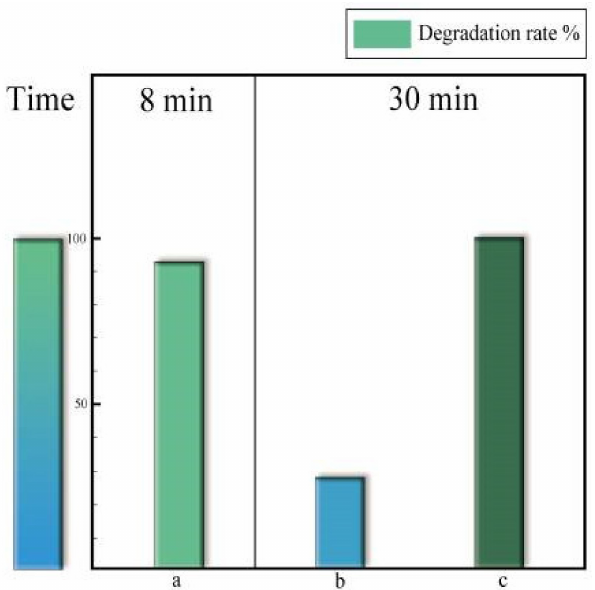
Figure 11. Degradation of BPA by three iron-based catalysts: ( a ) biochar loaded with CoFe 2 O 4 nanoparticles [39], ( b ) Fe 3 O 4 [87], and ( c ) CuO–Fe 3 O 4 –BC [88].